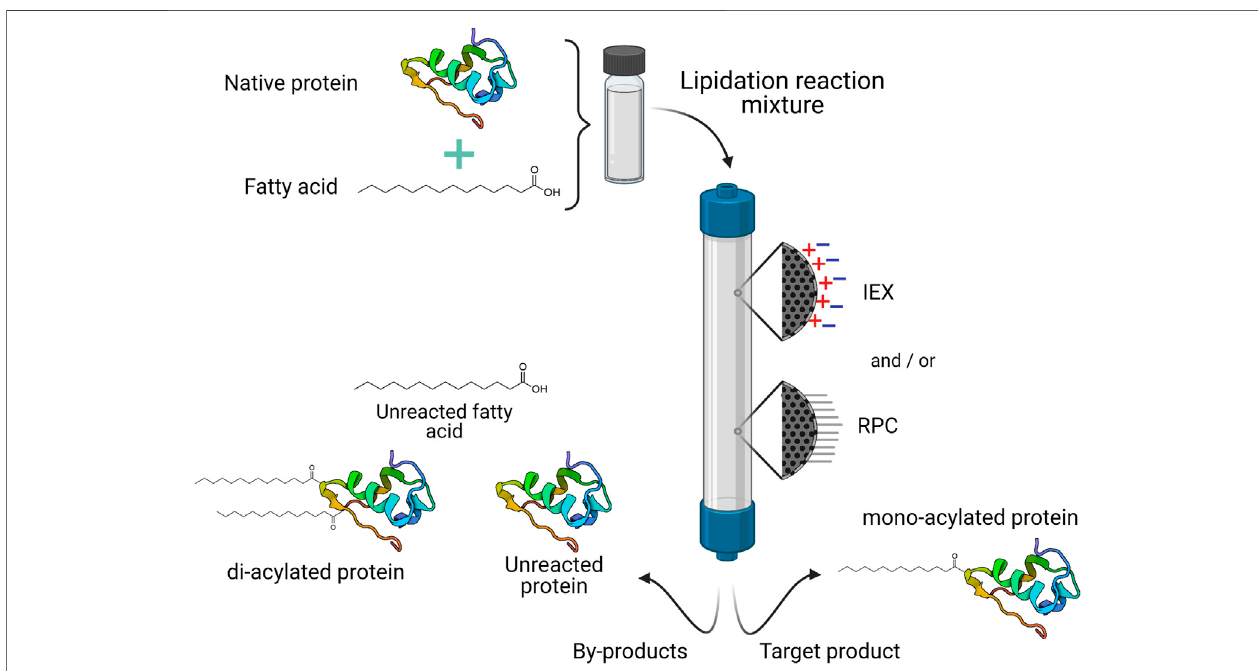
FIGURE 4 | General puri fi cation process for commercial lipidated proteins. One or two different chromatographic operational modes may be necessary to isolate the target product (usually the mono-acylated protein) from the lipidation reaction mixture. IEX, ionic exchange chromatography; RPC, reverse phase chromatography.